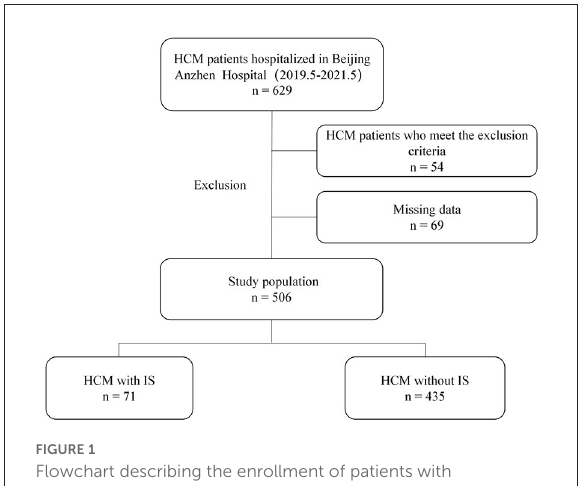
FIGURE1 Flowchart describing the enrollment of patients with hypertrophic cardiomyopathy (HCM) complicated by ischemic stroke (IS).